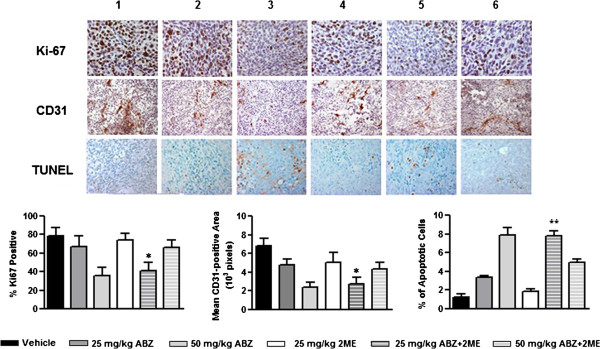
Effect of ABZ, 2ME, and their combination on inhibition of tumor cell proliferation, angiogenesis, and apoptosis in HCT-116 subcutaneous tumor. Ki67-positive cells (brown) were counted and reported as the percentage of the total number of cells in proliferative phases in each field. CD31-positive vessel area (brown) were measured per high-power field (103 pixels). Cells underwent apoptosis (brown) were counted and reported as the percentage of total cells. (1) Vehicle control, (2) 25 mg/kg ABZ, (3) 50 mg/kg ABZ, (4) 25 mg/kg 2ME, (5) 25 mg/kg ABZ plus 2ME, and (6) 50 mg/kg ABZ plus 2ME. (*P < 0.05 and **P < 0.001 compared with single agents).